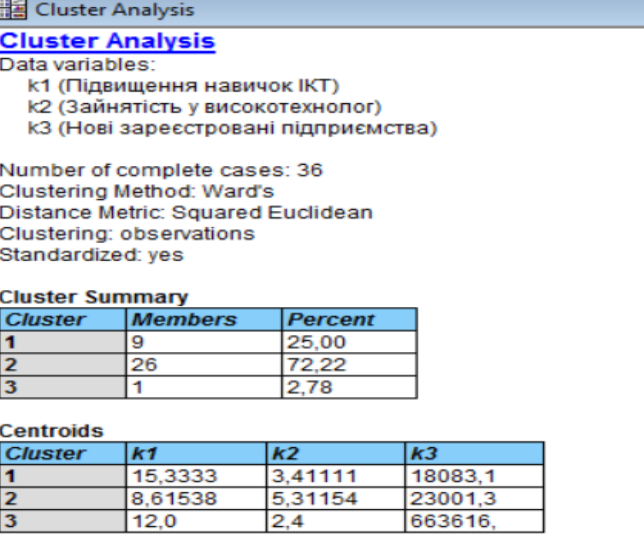
Figure 1. Results of cluster analysis by Ward's